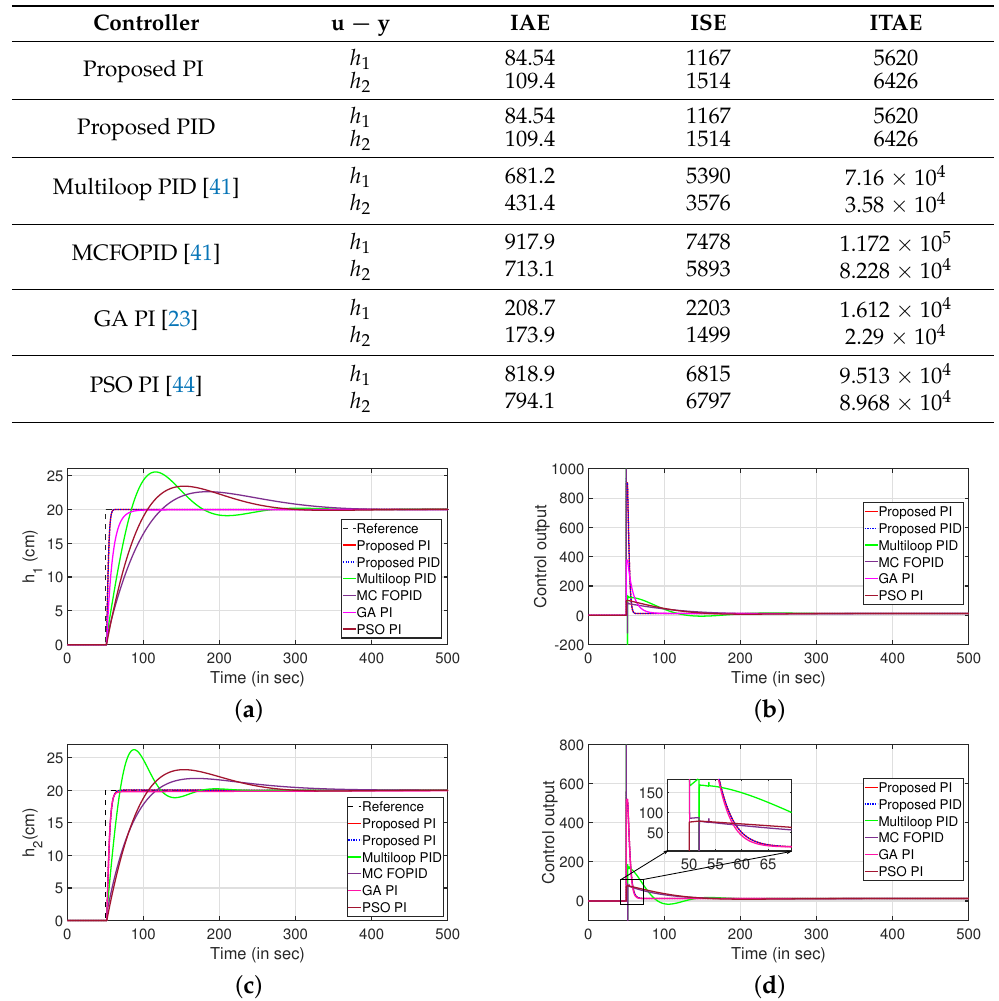
Figure 7. Servo response. ( a ) Level Variation in tank 1. ( b ) Control output. ( c ) Level Variation in tank 2. ( d ) Control output.